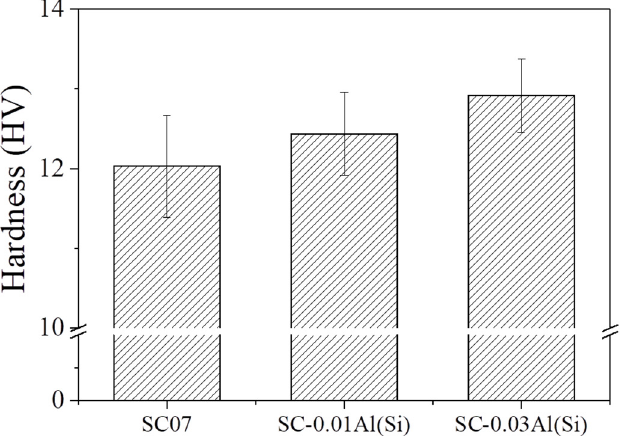
Figure 5. Hardness of the SC07, SC-0.01Al(Si), and SC-0.03Al(Si) solders [27].